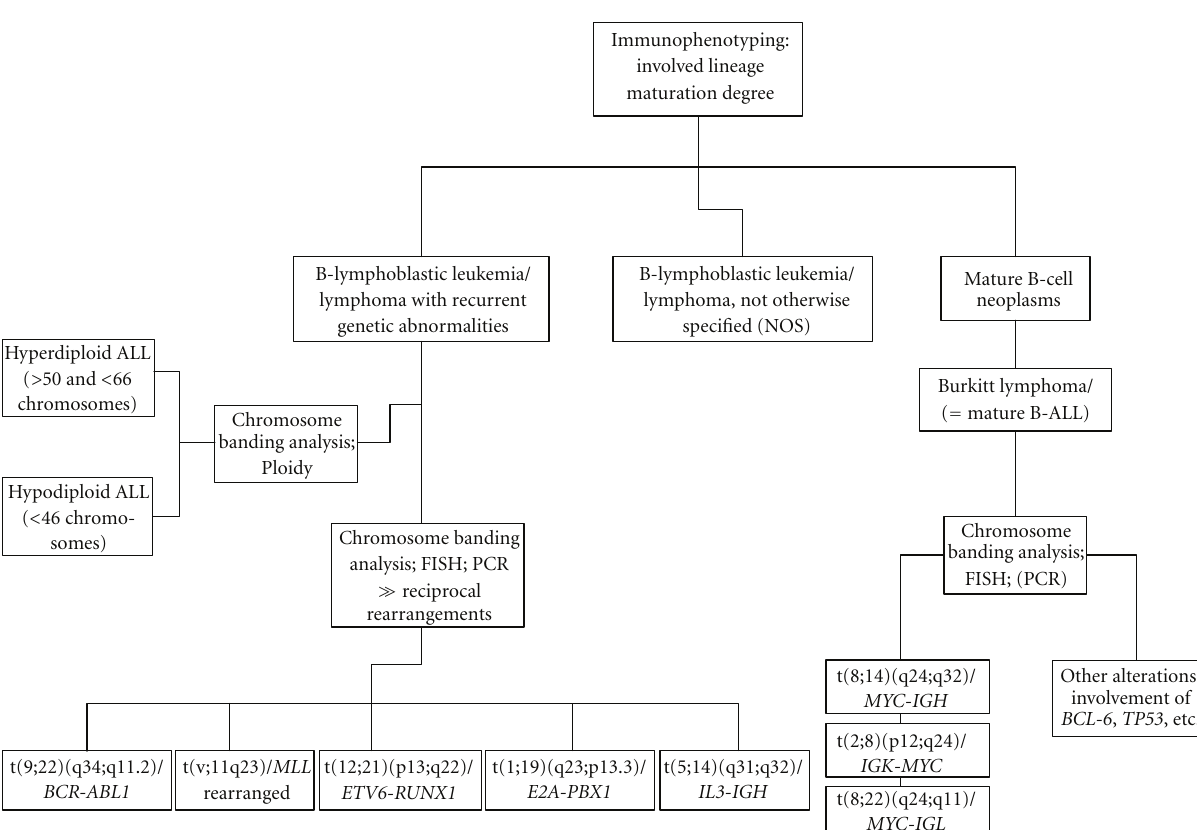
Figure 1: Classification of di ff erent B-lineage ALL/LBL entities according to WHO, 2008